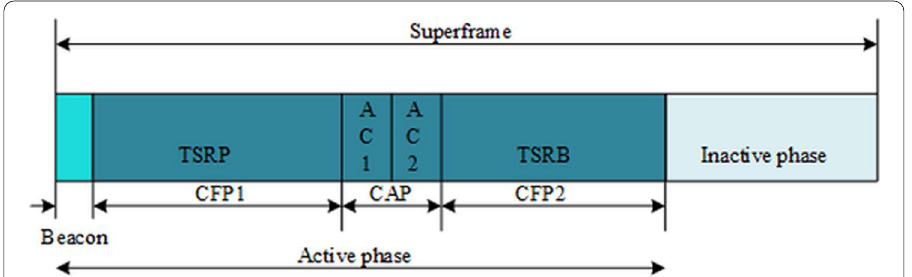
Fig. 9 A priority‑guaranteed MAC superframe